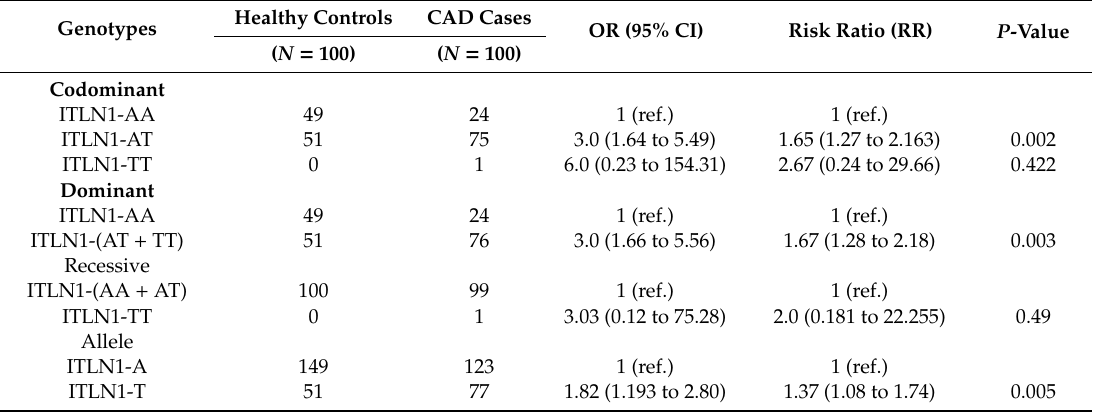
Table 5. Association of omentin rs2274907A > T gene variation with CAD.